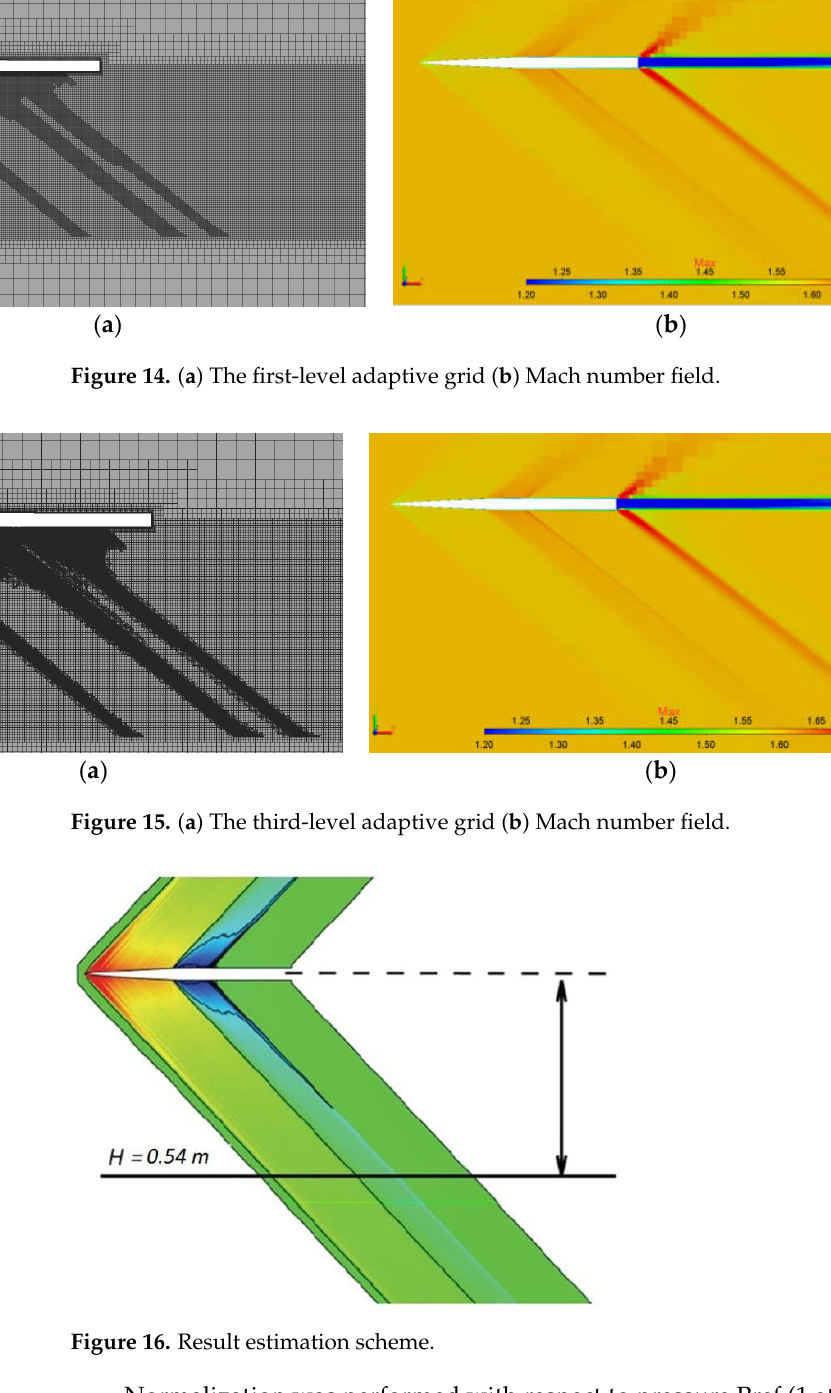
Figure 17. Normalized variation of static pressure.